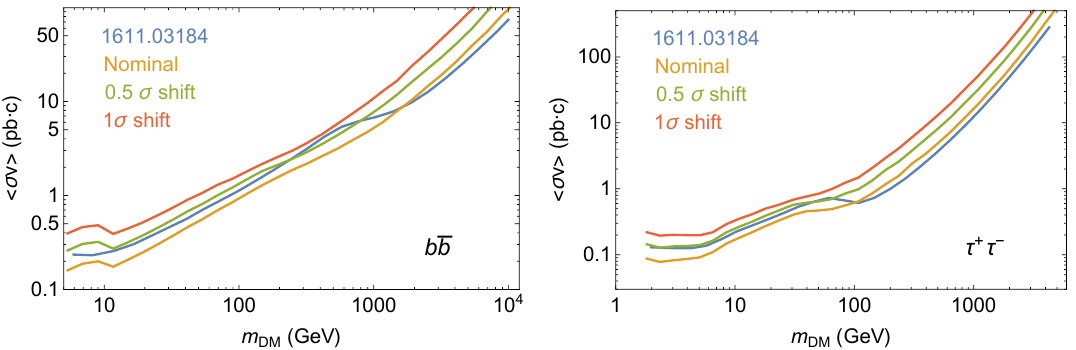
Figure 14 . The bound on dark matter annihilation cross-section using di(cid:11)erent fraction system- atic uncertainty shifts in central values compared to those from Fermi-LAT (in blue). Given the value accurate reproduction for 0.5 (cid:27) shift, we use this to approximate a proper treatment of the correlations in systematic uncertainties. Left: b (cid:22) b . Right: (cid:28) + (cid:28) (cid:0) . the correlation of the systematic uncertainty on the J -factors between dwarfs. As this in- central value (using (cid:27) = 0 : 6), as this was determined to replicate constraints unmeasured